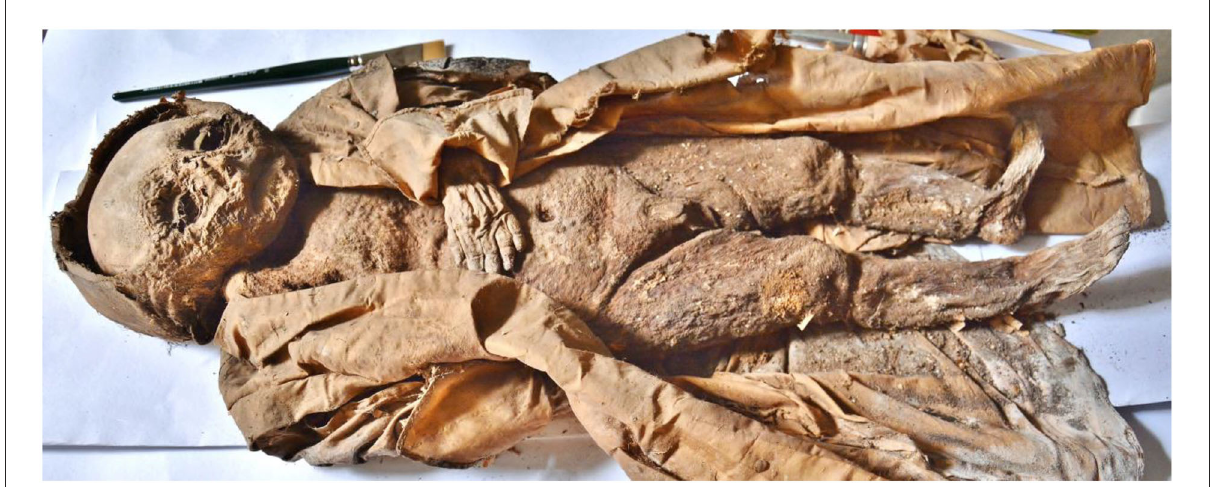
FIGURE1 The infant mummy of the Hellmonsödt crypt. Overview of the complete body with the silk coat.